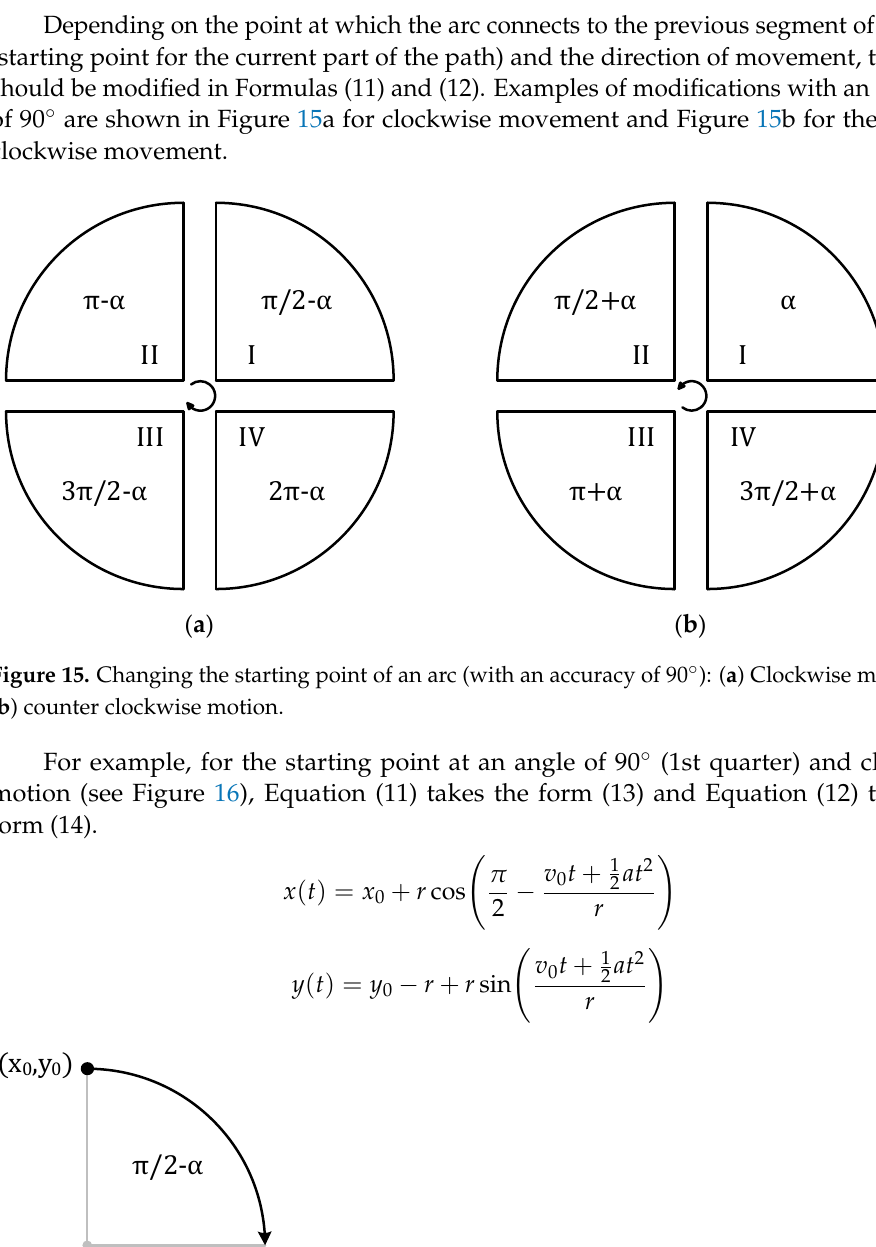
Figure 16. An example of a clockwise circular motion starting at 90°.